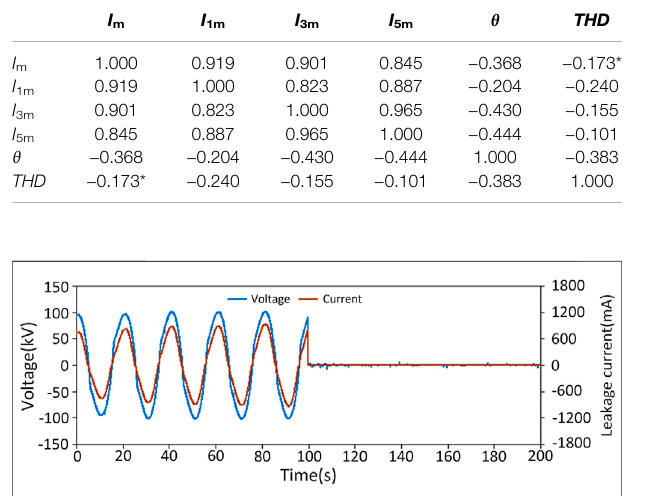
FIGURE 8 | The voltage and current waveform of fl ashover.